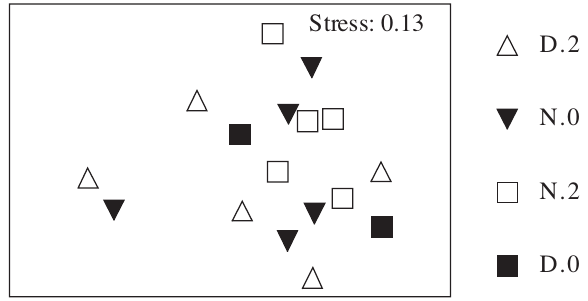
F IG . 6. – Non-parametric multi-dimensional scaling plot of fish lar- vae for the factors: Height (2=in the water column; 0= on the Posidonia oceanica leaf canopy) and Diel period (D=day; T ABLE 4. – Results of PERMANOVA for fish larvae considering the factors Height and Diel period. * Significant at p<0.05. ns no significant difference.